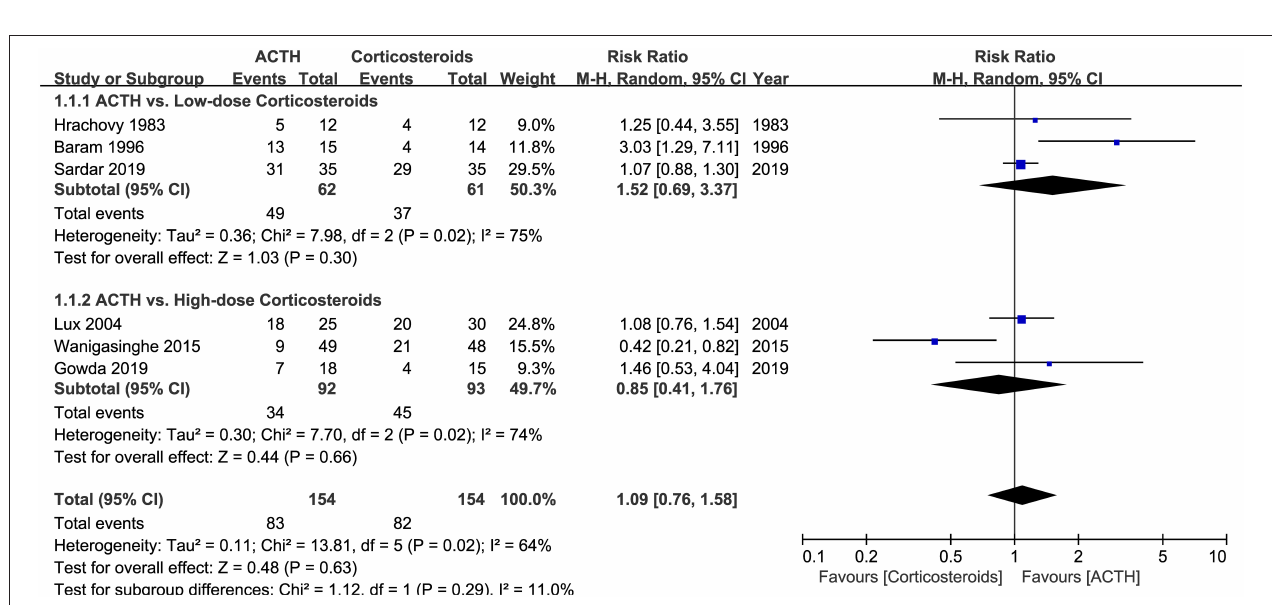
Frontiers in Neurology |